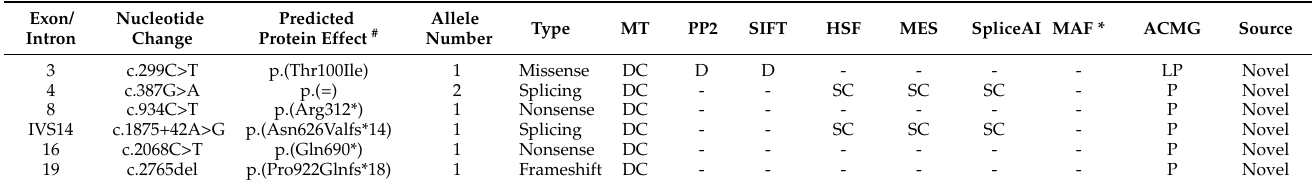
Table 1. Novel KIF11 variants identified in this study and analysis of the variants by predictive.